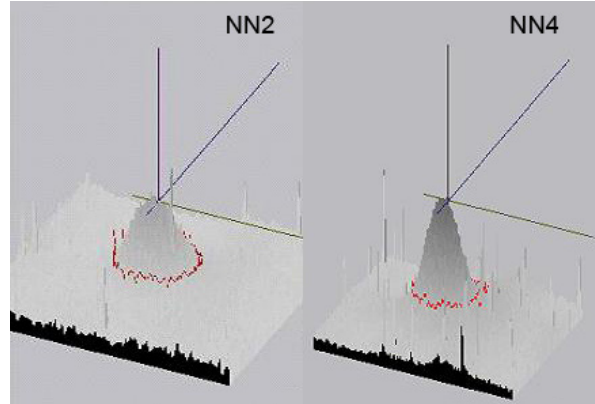
Figure 3. The three-dimensional images of NN1 and NN3 spots clearly showing individual peaks. No peaks were detected for NN2 and NN4 using the ImageMaster 2D ® Platinum